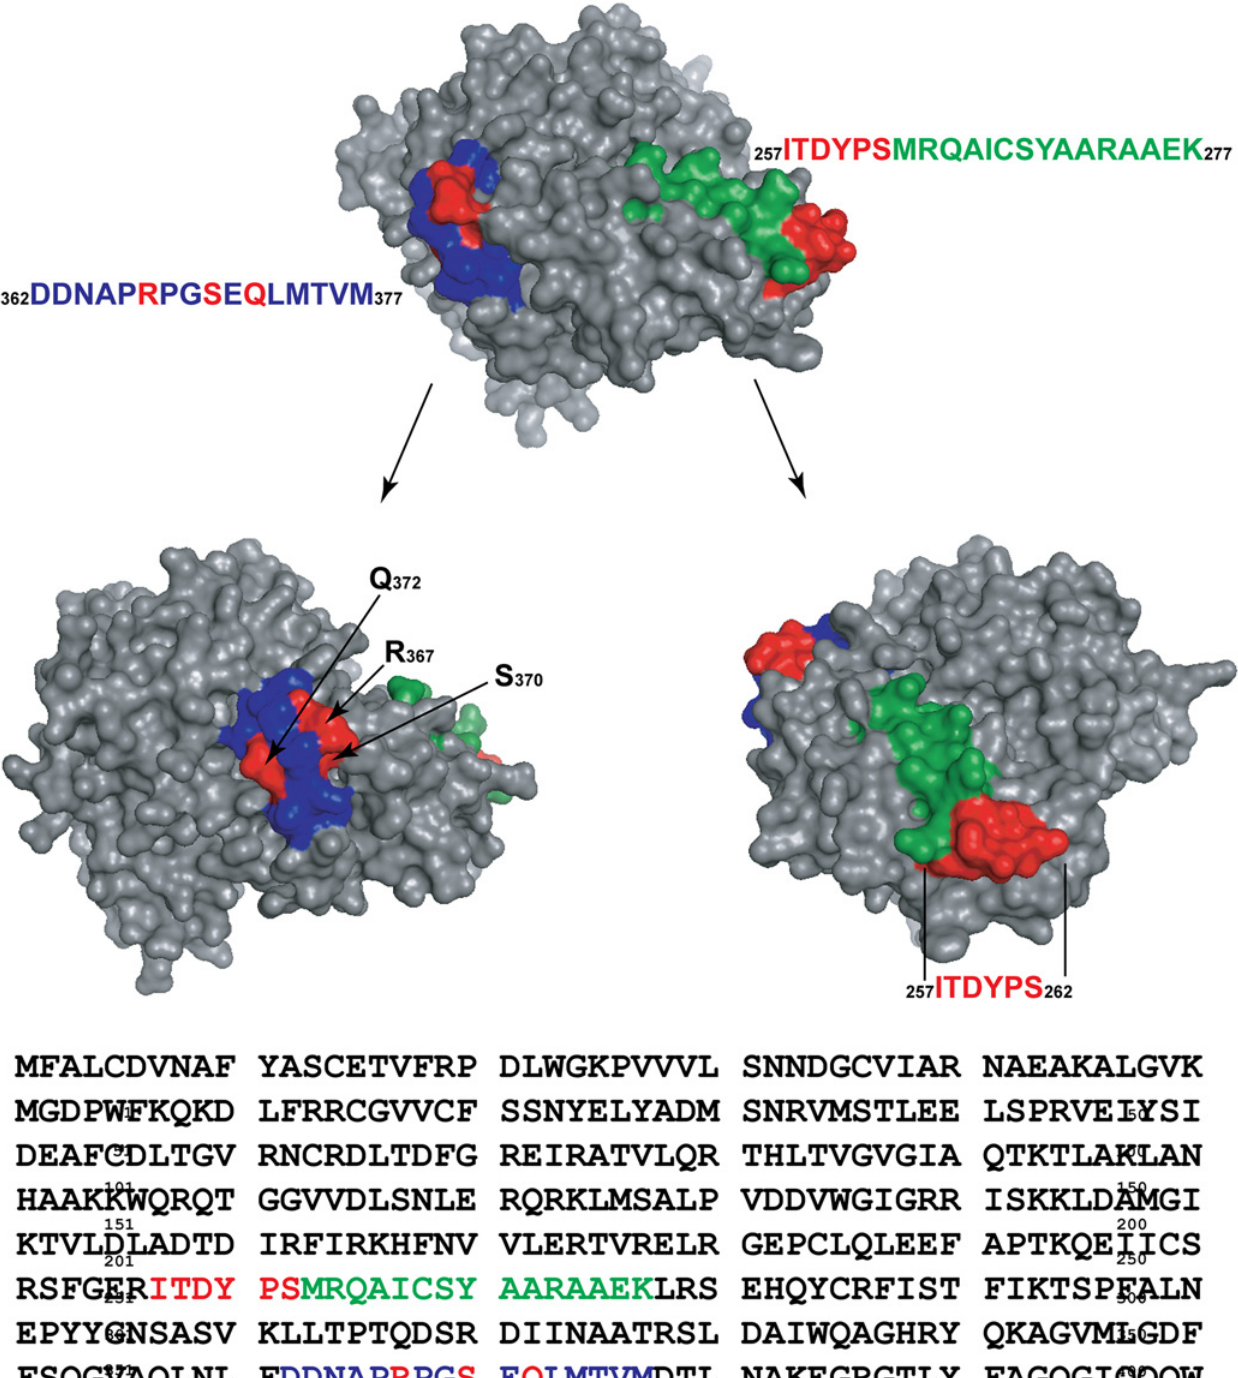
Fig 15. Structural model for UmuC. The model was generated by the program Phyre2 ( P rotein H omology/analog Y R ecognition E ngine V 2.0) [79] using intensive modeling mode, and exhibits a close structural homology to the known structure of polymerase Dpo4 (S2 Fig). The locations of cross-linked peptides 1 (blue) and 2 (green) are highlighted, with particular amino acid residues involved in cross-linking highlighted in red.